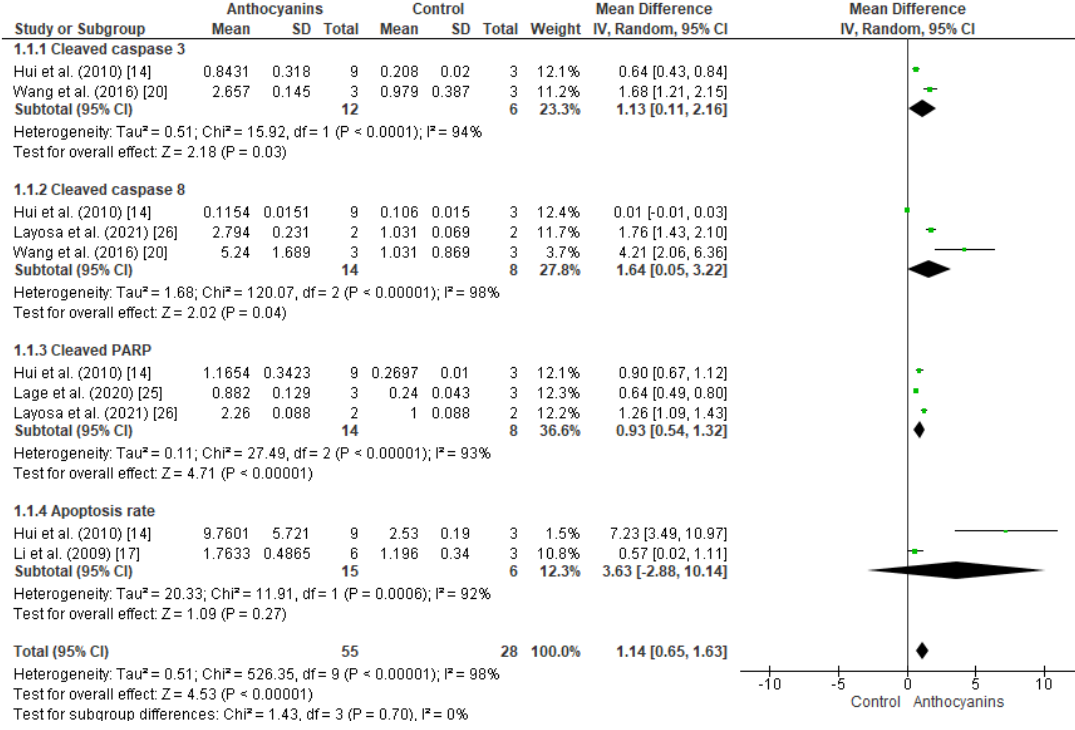
Figure 6. Forest plot of the meta-analysis comparing the anthocyanins TNBC cell line versus the untreated controls in apoptosis induction. IV: inverse variance based on the mean difference; CI: confidence interval. The green box in the middle of each horizontal line represents the point estimate of the effect for each study (the larger the size of the green box, the greater the weight of the study). The black diamond represents the effect estimate of all meta-analysis studies. The position of the diamond indicates which group was significant in modulating the parameter (e.g., if the diamond is on the right side, it means that the anthocyanin group modulated the parameter. However, if it touches the central line the difference between control and anthocyanin groups did not reach significance) [14,17,20,25,26].